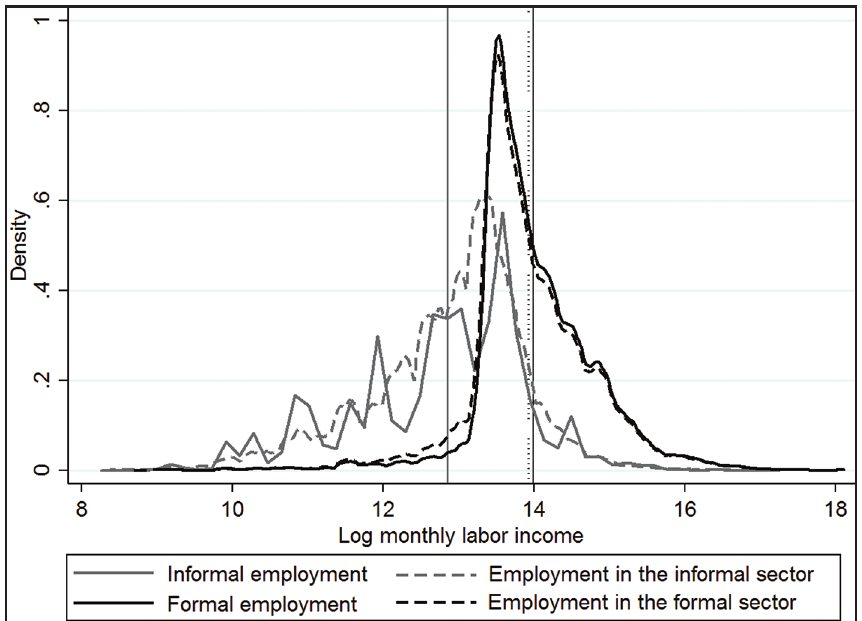
Distribution of log monthly labor income by